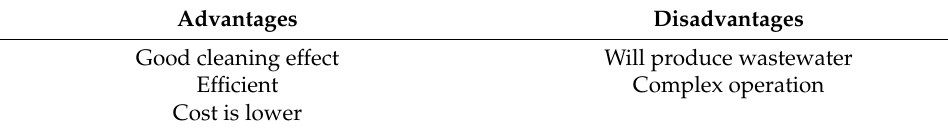
Table 4. The advantages and disadvantages of chemical cleaning.